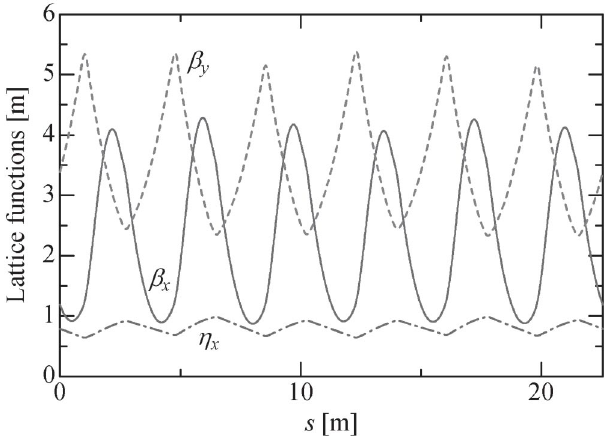
FIG. 11. Real-space configuration (top view) of the laser- cooled beam obtained in the MD simulation of Fig.